Question: Give a one-sentence summary of this figure.
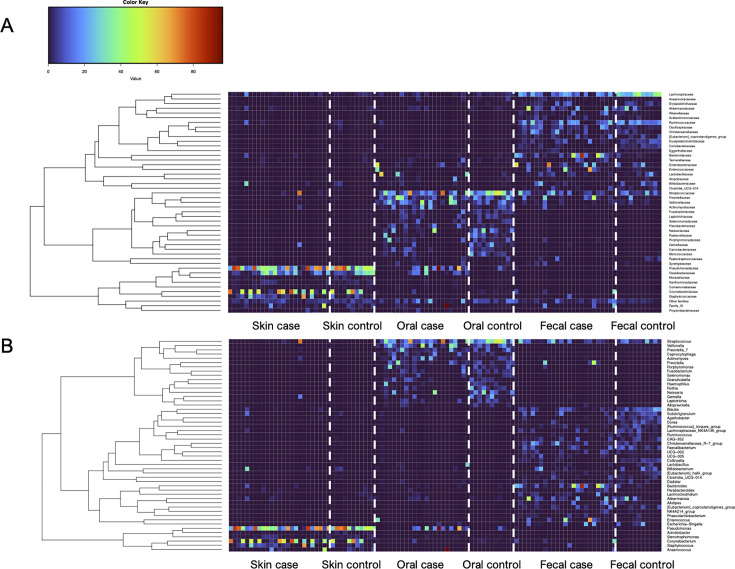
Answer: Oral, gut, and skin microbiota signatures of patients with heart valve disease with and without infective endocarditis. Heatmap showing Ward-linkage clustering based on Pearson’s correlation coefficients of the relative abundance of families ( A ) and genera ( B ) in the oral, gut, and skin microbiota of cases and controls. Only taxa with relative abundance ≥1% in at least 20% of samples for each study group are shown. Those with relative abundance <1% were grouped as “Other.” See also Fig. S1 and S2 .